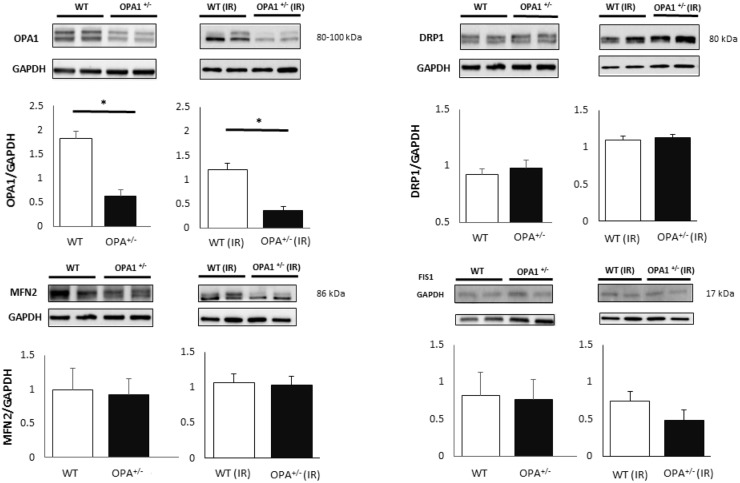
Baseline and post-I/R fission and fusion protein expression.Opa1, Mfn2, Drp1, and Fis1 expression assessed by means of western blotting at baseline (n = 6/group) and after I/R (n = 3-6/group). GAPDH was used as a loading control. Values are mean ± SEM. * p<0.01.